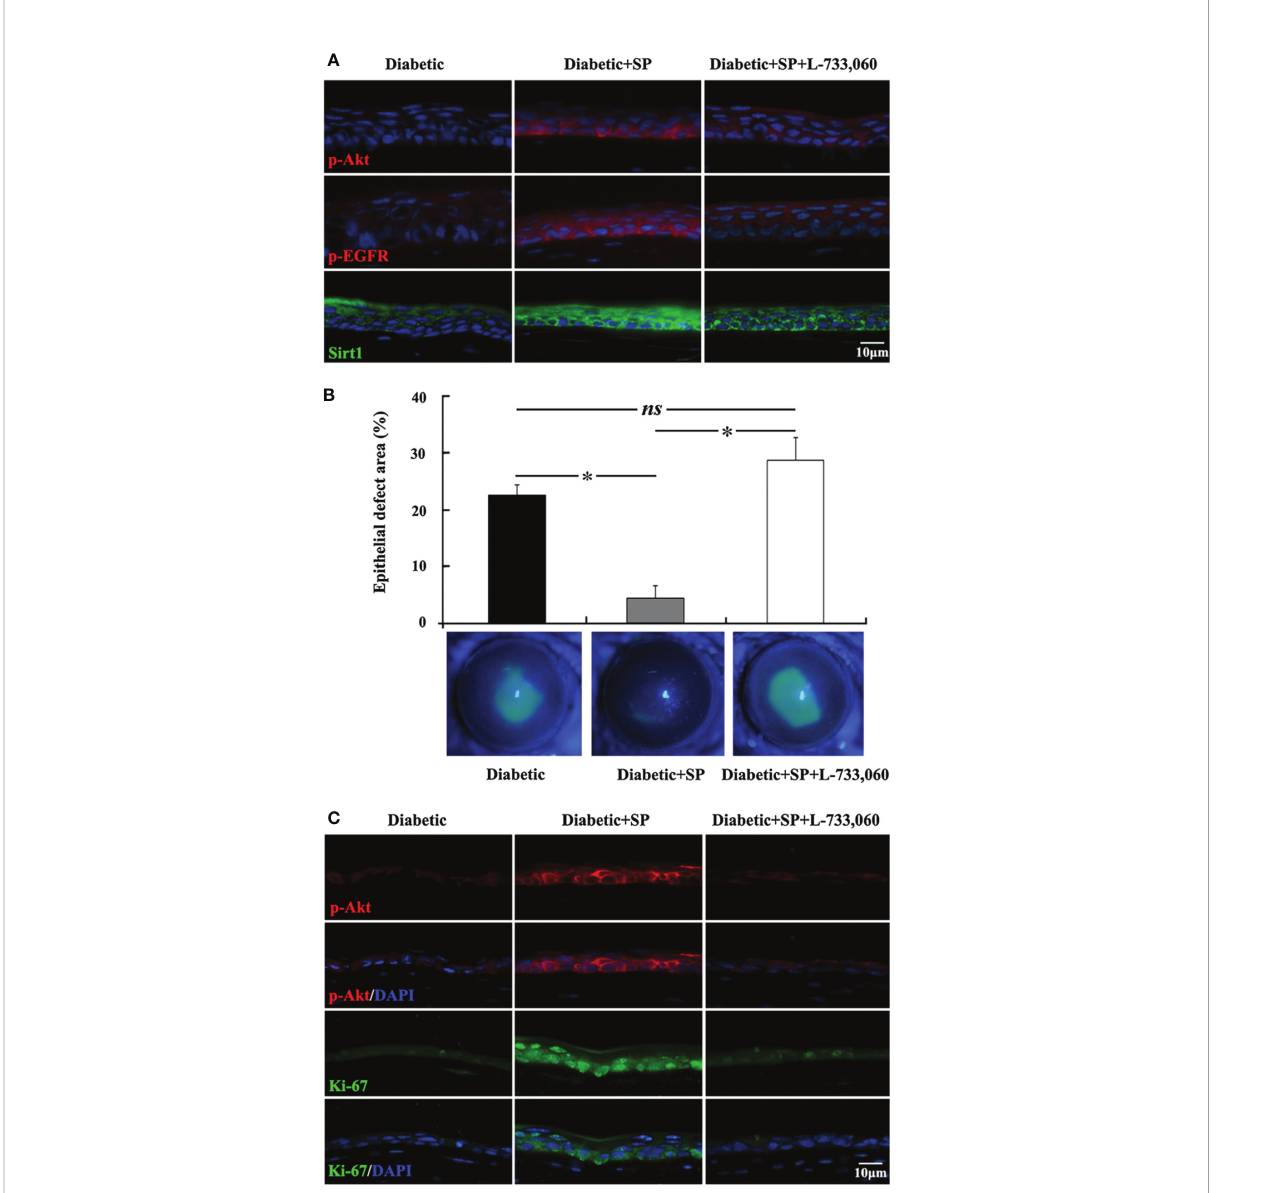
FIGURE 2 SP-NK-1R signaling regulates diabetic corneal epithelial wound healing. (A) In the unwounded corneal epithelium, the elevation of p-Akt, p- EGFR, and Sirt1 level by SP application was attenuated in NK-1 receptor antagonist L-733,060-injected SP-treated diabetic mice. (B) L-733,060 injection reversed the promotion of SP on diabetic corneal epithelial wound healing. (C) L-733,060 treatment reversed the promotion of SP on p-Akt activation and proliferation in the regenerated corneal epithelium. ns, no signi fi cance; *p< 0.05. (ref